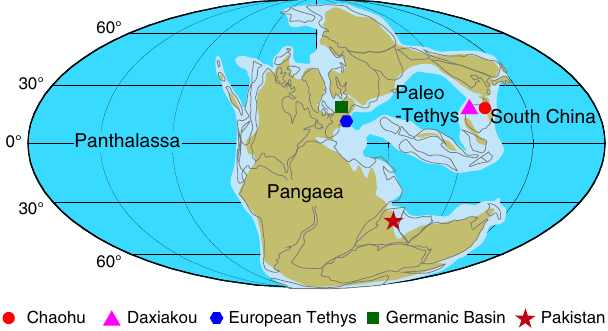
Fig. 4 Early Triassic global paleogeographic map. The map is modi fi ed from Christopher Scotese (http://www.scotese.com) with localities of data shown in Figs. 5 astrochronology (Methods) is employed for the noise model veri fi cation.